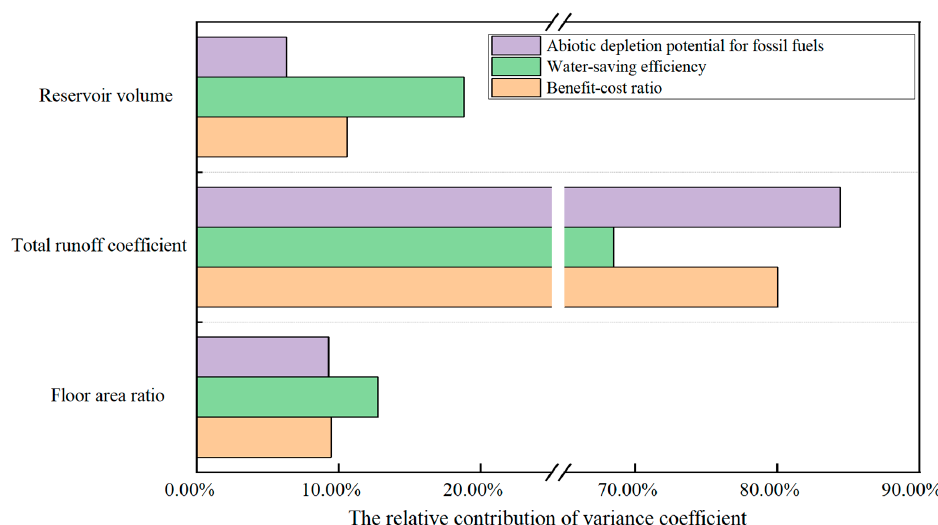
Figure 7. Analysis of source of uncertainty for objective functions.